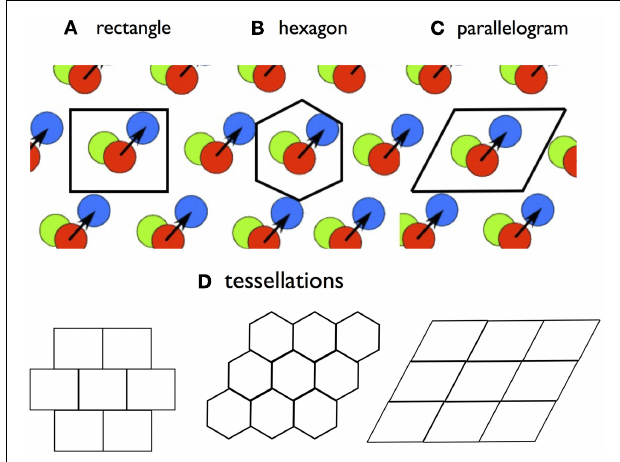
FIGURE 4 |The tile concept. A tile is a bounded region that contains one-and-only one activity bump from each grid cell in a rigid module. A tile boundary will tessellate, in that it can be placed edge-to-edge to cover a surface.Three possible tile boundary shapes are (A) rectangles; (B) hexagons; and (C) parallelograms. (D) shows tesselation patterns. No single tile boundary will contain all of the SIVs of a rigid module, but the hexagon contains all of the SIVs connecting to a grid cell with a bump at the center.